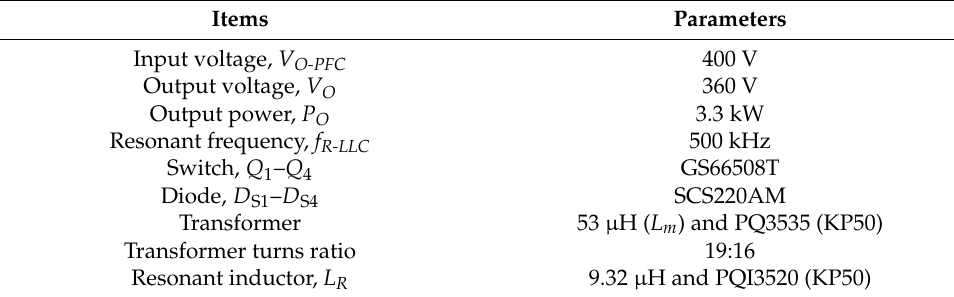
Figure 6. Layout of two PCBs for 3D-PCB design. ( a ) Bottom PCB for lossy components. ( b ) Top PCB for bulky components. The heat spreader is located underneath the bottom PCB to dissipate heat effectively. Table 2. Designed parameters of 3.3 kW full-bridge (FB) LLC resonant converter.